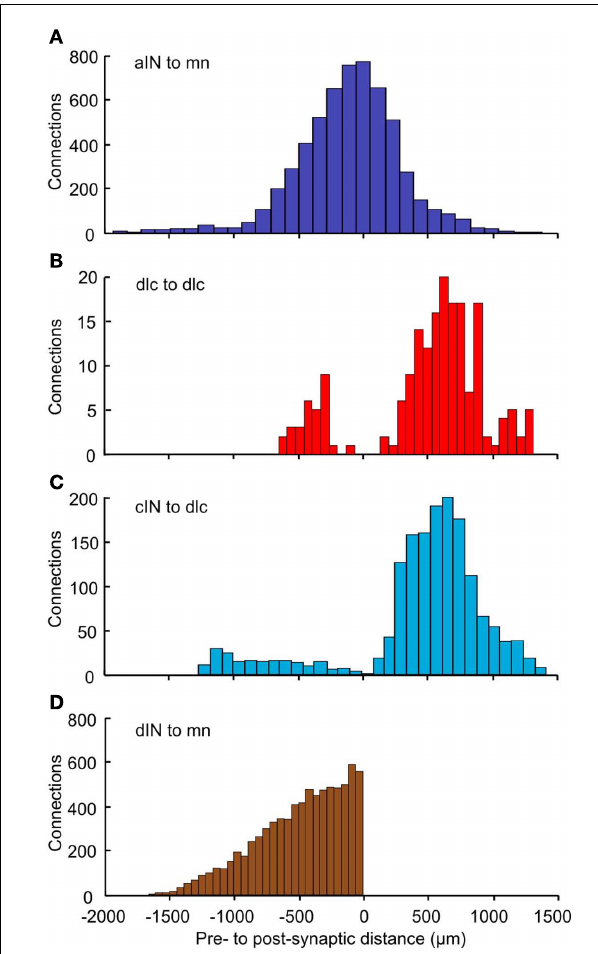
FIGURE 8 | Distributions of the number of connections as a function of distance. For each pair of neuron types, distance zero is the soma position of the post-synaptic neurons; the bars show the relative positions of the presynaptic neurons. Connections are shown: (A) from aIN to mn; (B) from dlc to dlc; (C) from cIN to dlc; (D) from dIN to mn. Colors (as in Figure 1 ) indicate the presynaptic neuron type. Bin widths: (A) = 111 μ m; (B) = 67 μ m; (C) = 90 μ m; (D) = 55 μ m.